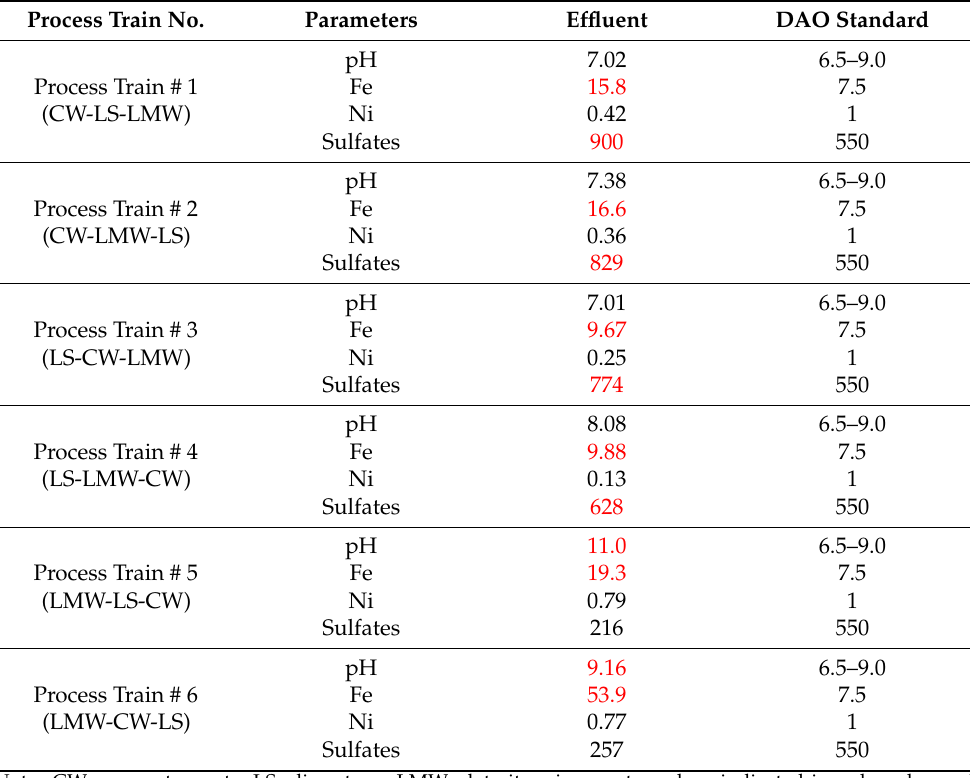
Table 8. Comparison between the Effluents and the DAO 2016–08 and 2021–19 Standards. Process Train No.